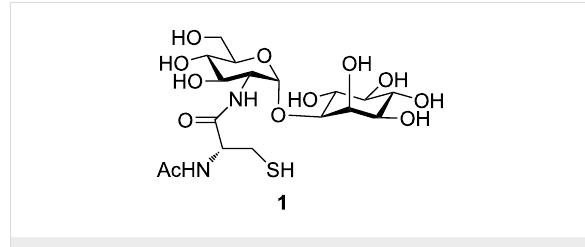
Figure 1: Structure of mycothiol 1